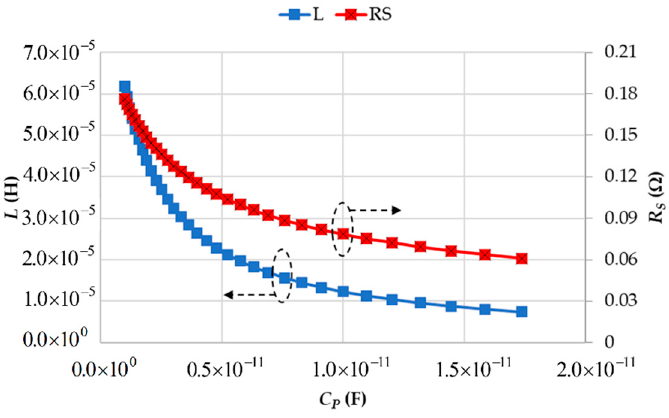
Figure 18. Inductance and series resistance characteristic for various parasitic-capacitance values.